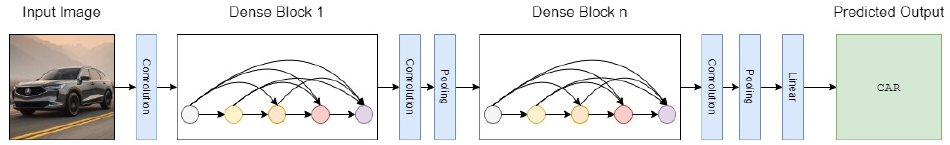
Figure 3. A general visual representation of convolution and pooling layers used to change feature map sizes between multiple ( 𝒏 ) dense blocks of CondenseNeXt architecture which allows it to efficiently extract information of features from an input image.